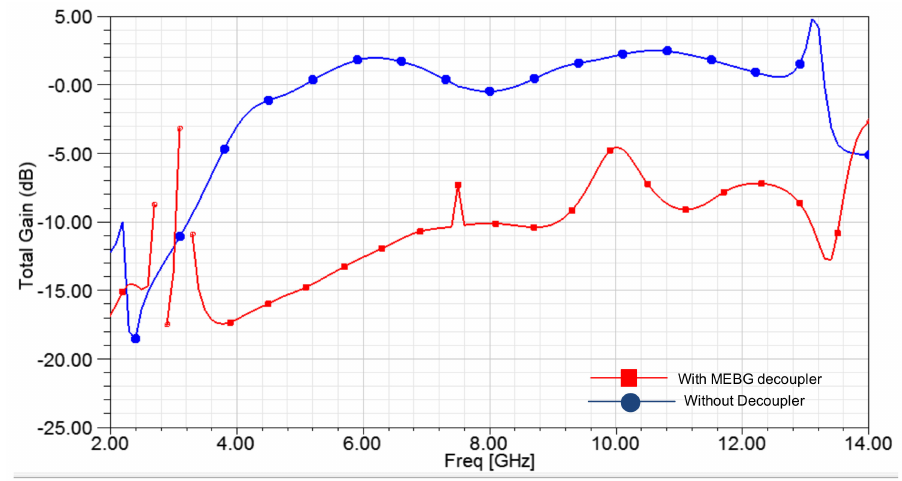
Figure 8. Antenna total gain with and without MBEG decoupling structure.